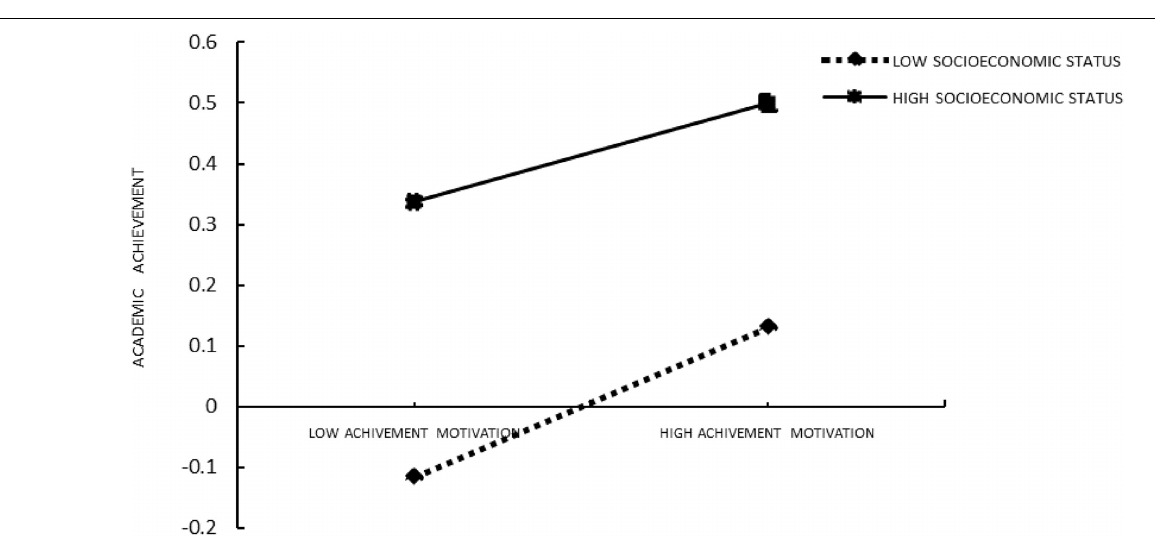
FIGURE 3 | Socioeconomic status moderated the relation between achievement motivation and academic